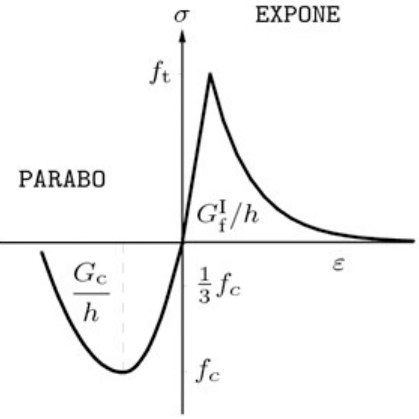
Figure 14. Stress/strain curve, showing the tensile and compressive behavior of masonry